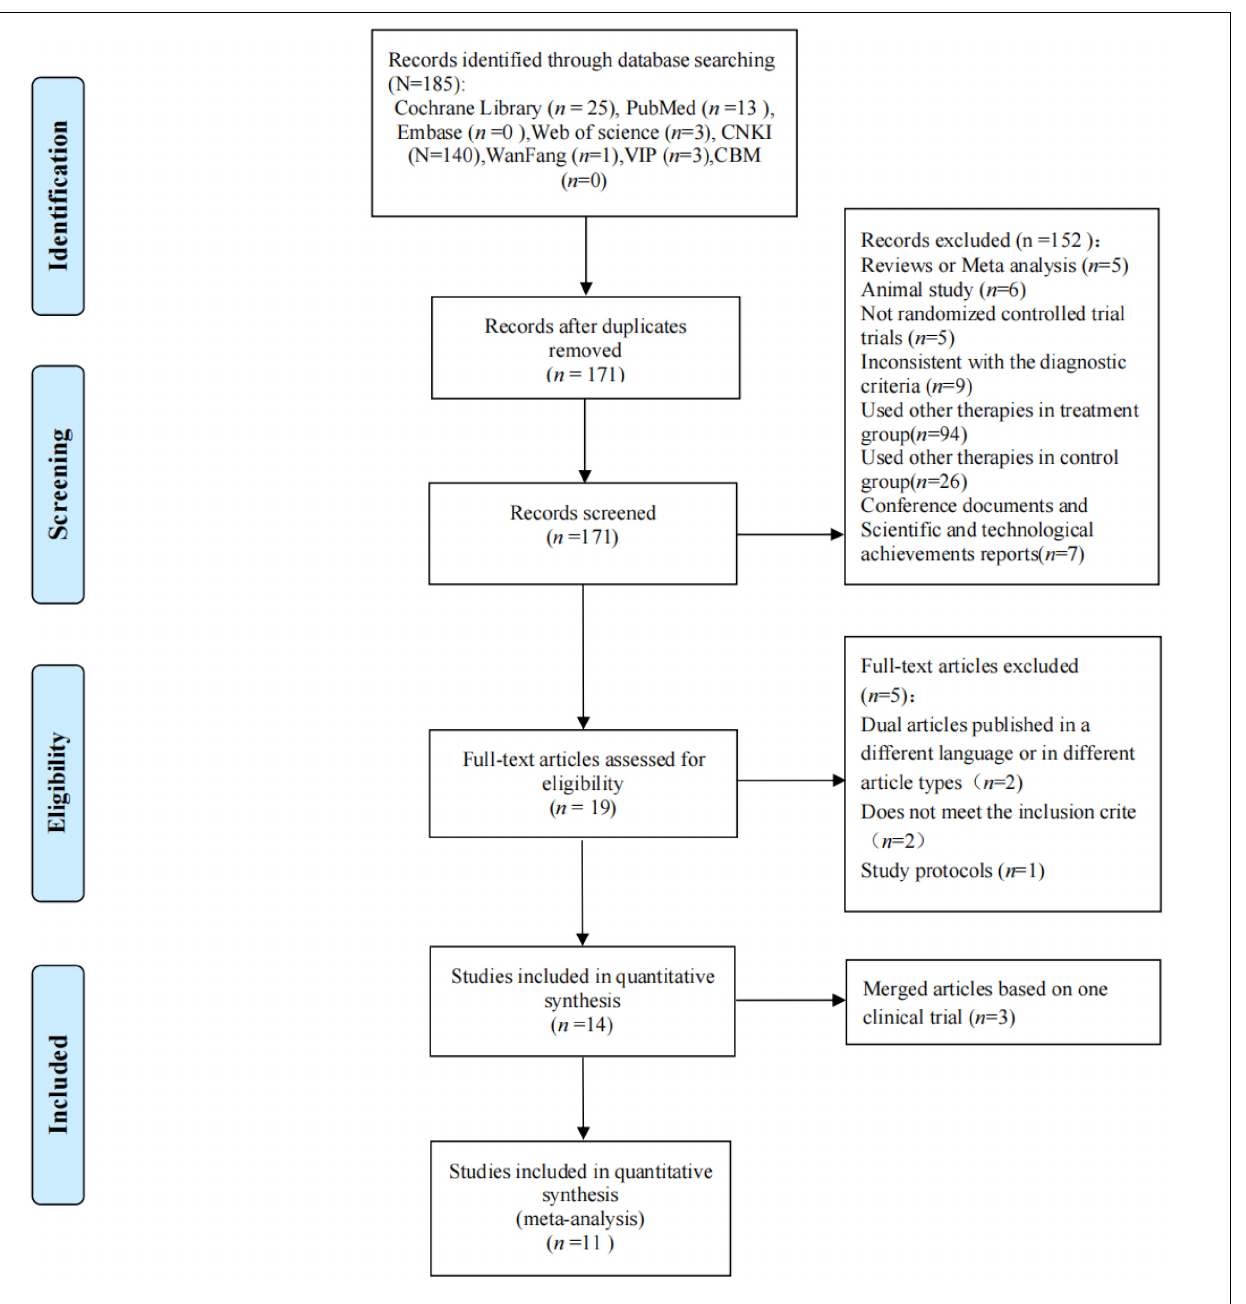
FIGURE 1 | Article screening